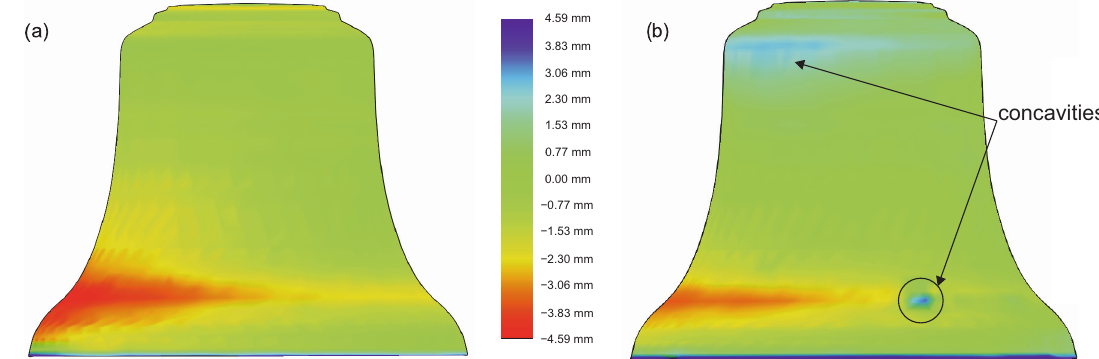
Figure 6. Quality control of the obtained 3D scans—external view: ( a ) CuSn20; ( b ) CuAl10Fe3Mn2.